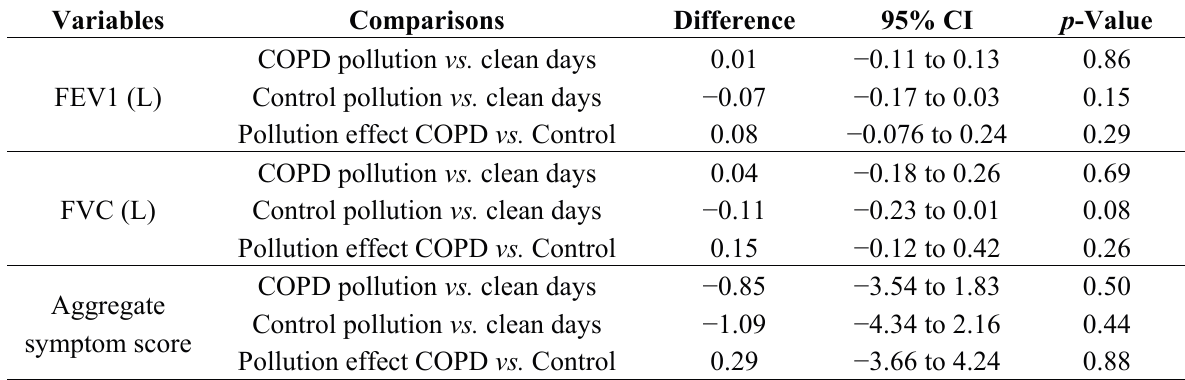
Table 6. Spirometry and aggregate symptom score on pollution vs. clean air quality days.